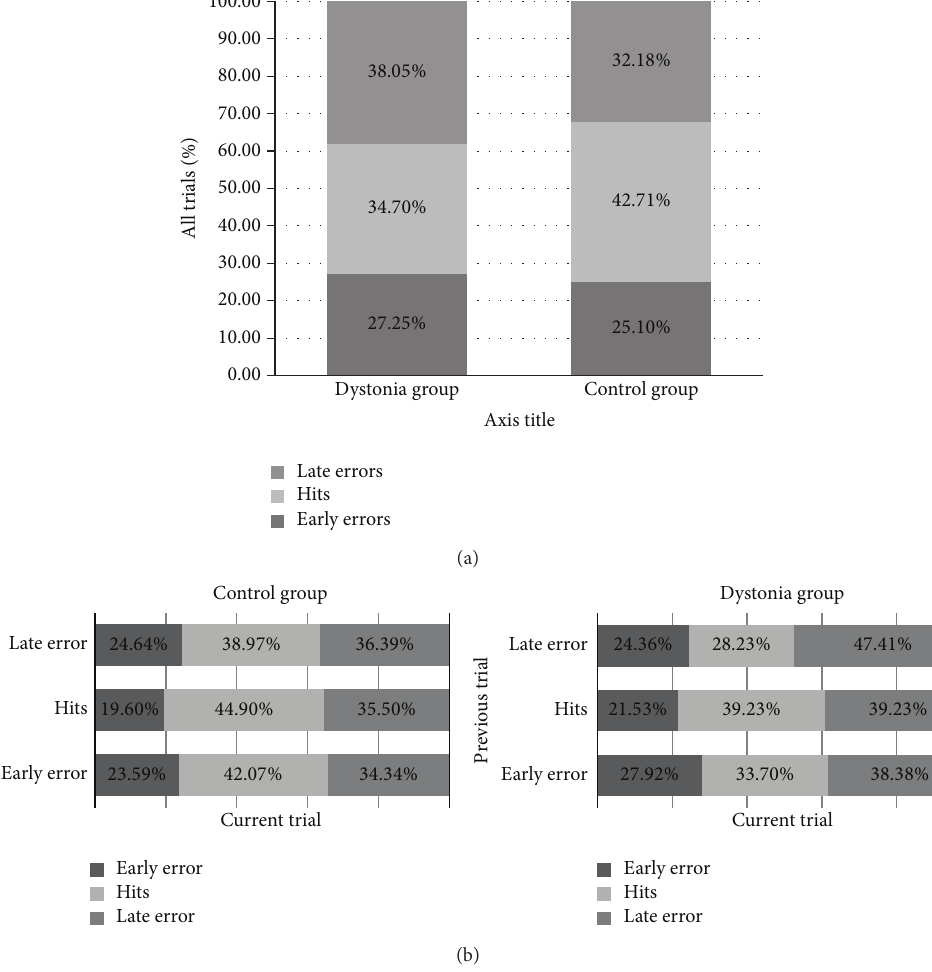
Figure 6: Error distribution. (a) Distribution of early and late errors in healthy subjects and cervical dystonia patients. (b) Trial-by-trial distribution of hits and errors: The effect of feedback and the impact of the success rate in the previous trial on the hit ratio and early/late errors distribution. In the graph, the error type distribution is presented as a function of the previous trial